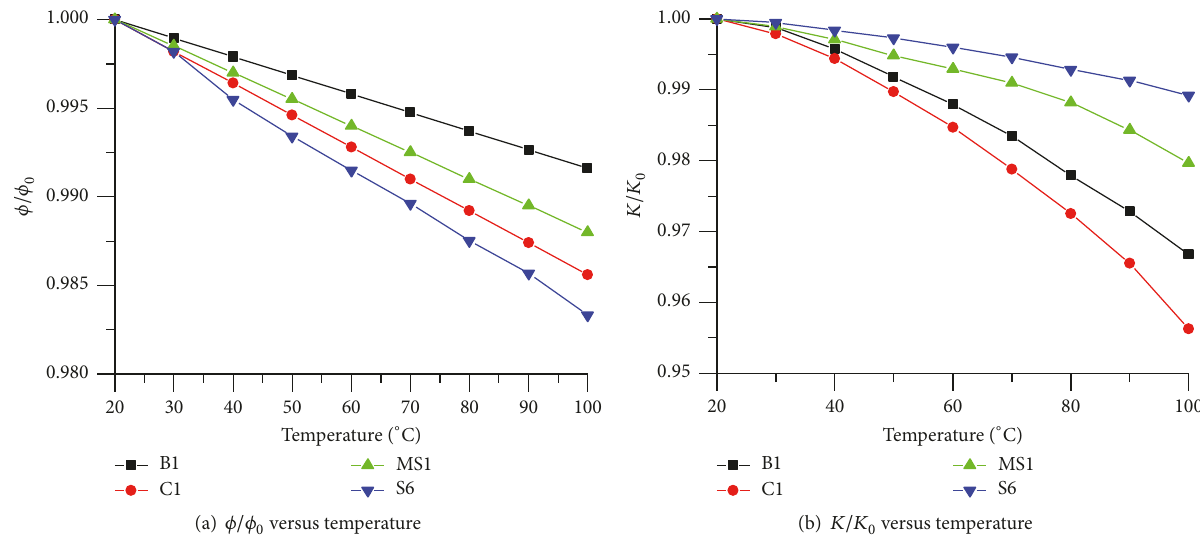
Figure 7: Variation of porosity and permeability with